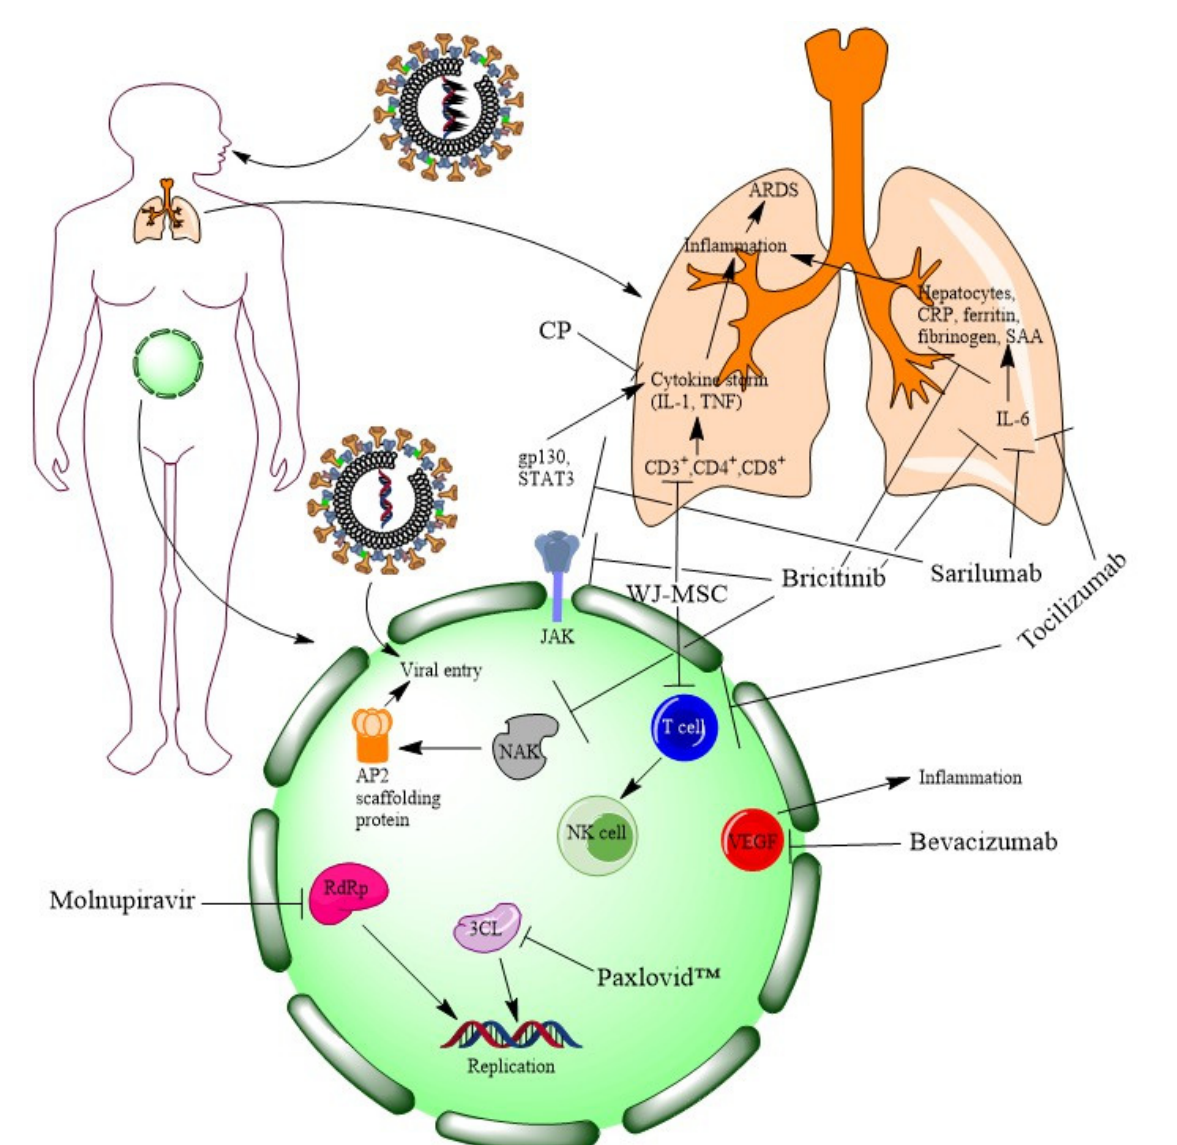
Figure 2. Comparison of adverse events observed in COVID ‐ 19 patients in clinical trials conducted with new discovered molecules.